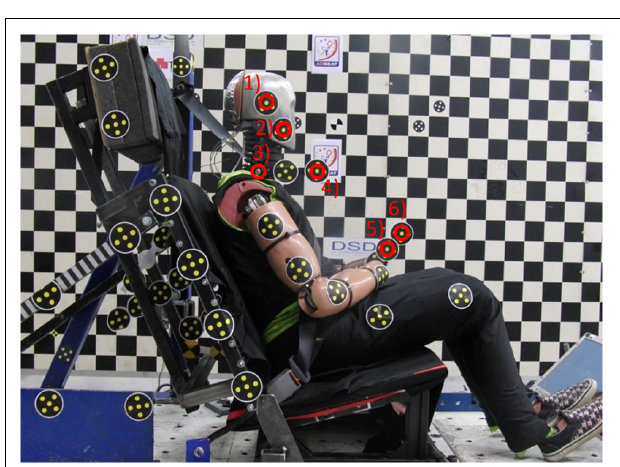
FIGURE 6 | The BioRID P50F prototype in the laboratory